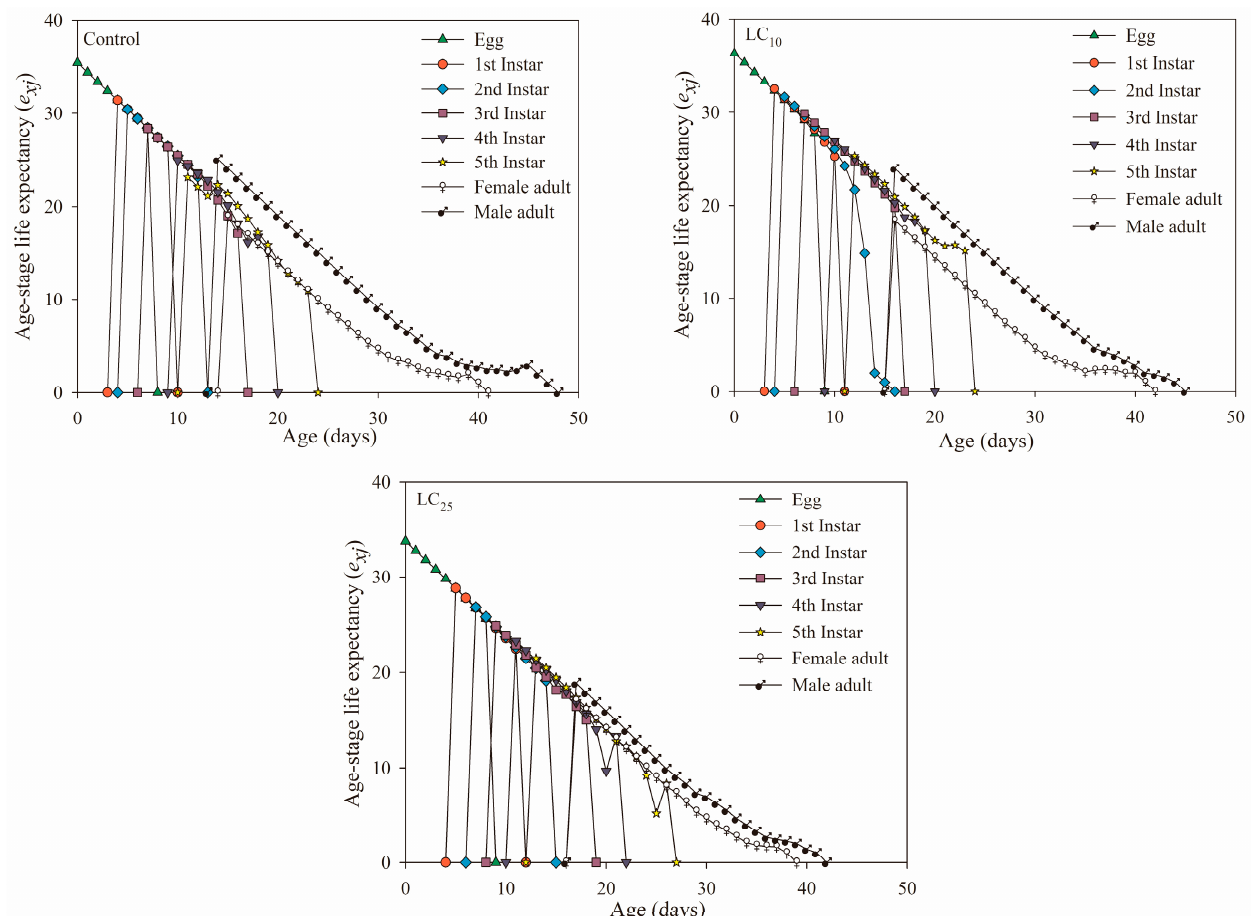
Figure 3. Age-stage specific life expectancy ( e xj ) in the control, Beauveria bassiana LC 10 - and LC 25 - treated F 1 generation of Sogatella furcifera .